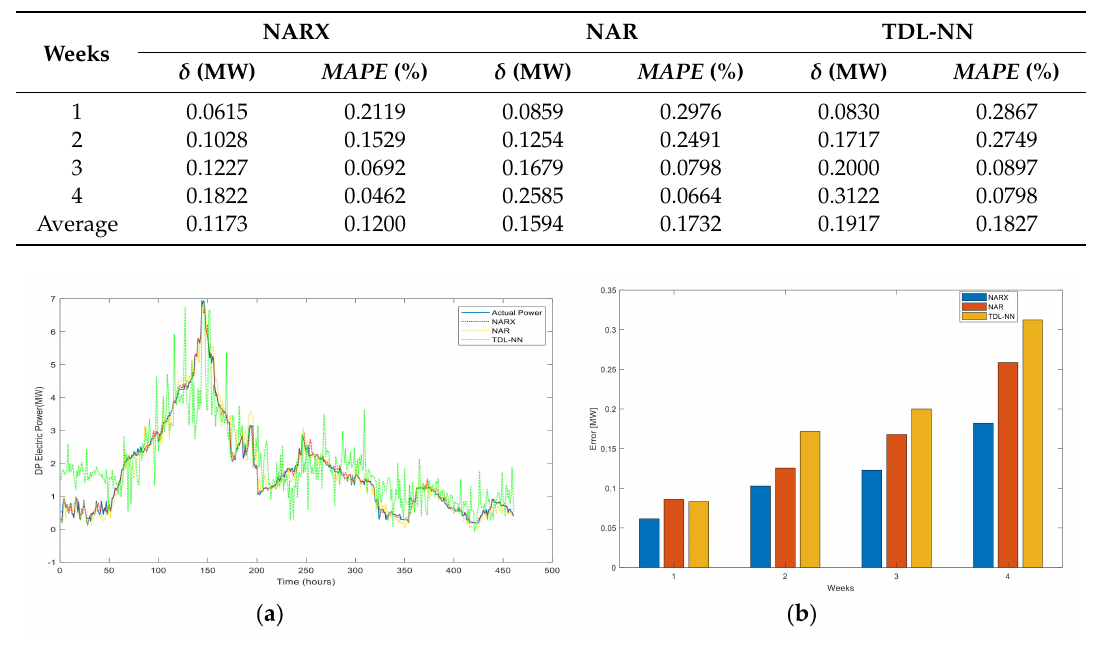
Table 4. Comparison of one-month DP load forecasting in di ff erent weather conditions.